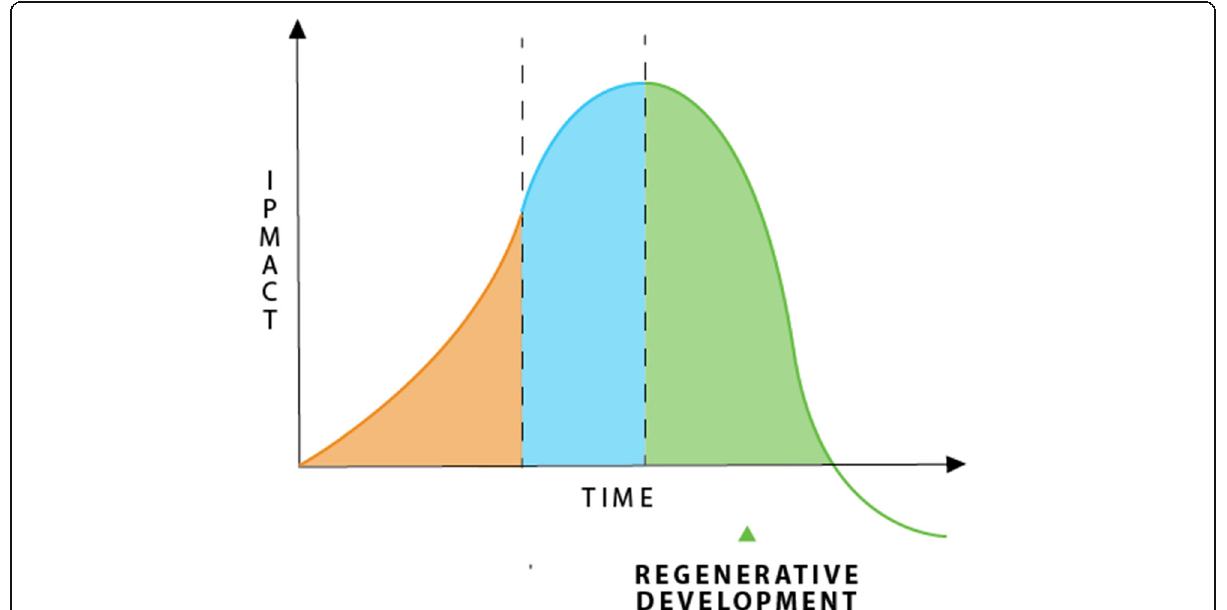
Fig. 5 Regenerative development in stage